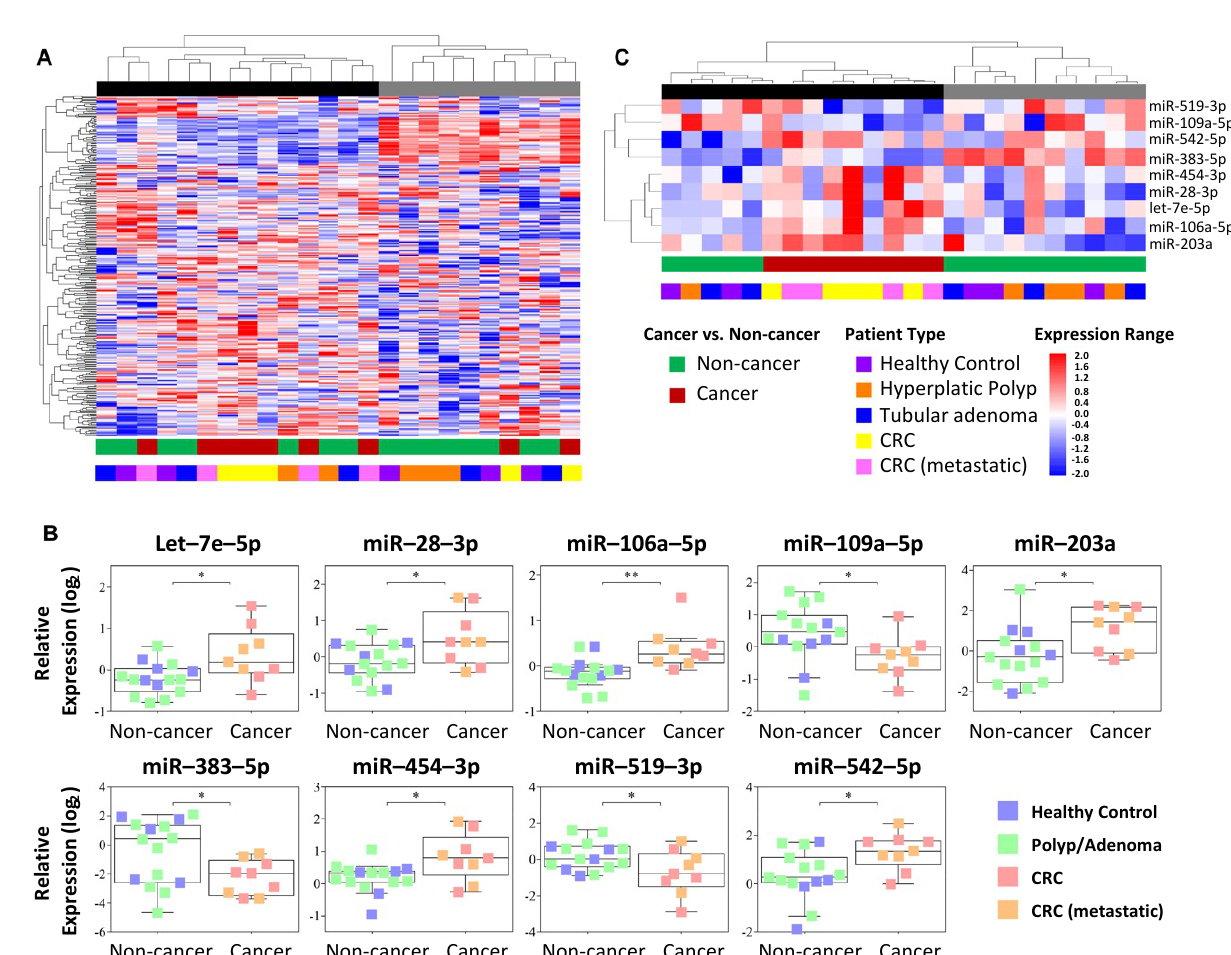
Figure 2. Hierarchical clustering analysis and plots representing plasma miRNAs. ( A ) Unsupervised hierarchical clustering analysis of 292 circulating miRNAs (RT-qPCR-TaqMan Low-Density Array (TLDA) assay). ( B ) Differential expression of nine miRNAs in the plasma of cancer versus non-cancer cases. The boxplot displays the first quartile, median, and third quartiles (interquartile range) and the minimum and maximum values excluding outliers of the log 2 -normalized relative quantification of the miRNAs in plasma (RT-qPCR-TLDA assay). ( C ) Supervised hierarchical clustering analysis comprising the nine differentially expressed miRNAs. The dendrogram demonstrates a stratification of samples into two clusters (black and gray) associated with the cancer status. The lines in the heatmaps represent individual miRNAs, and the columns represent each sample; * p < 0.05; ** p < 0.01 ( t